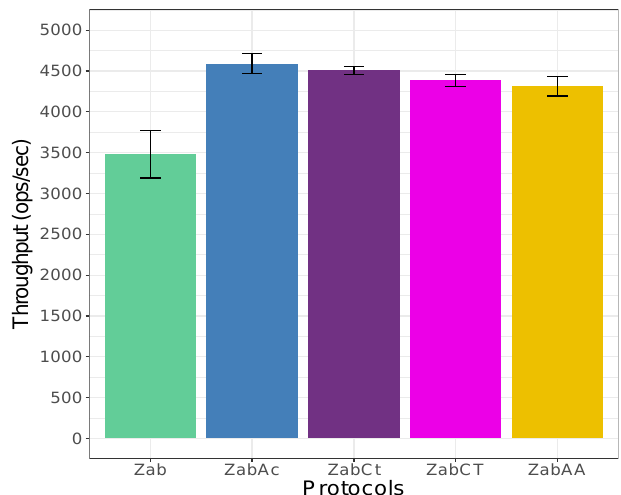
Figur e 3. Throughput comparison for WR = 100%.